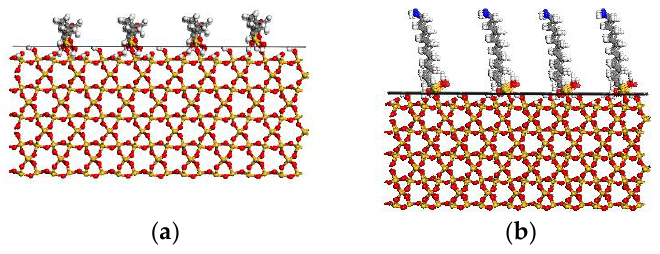
Figure 4. ( a ) Side view of A174-modified S; and, ( b ) side view of A2783-modified S.